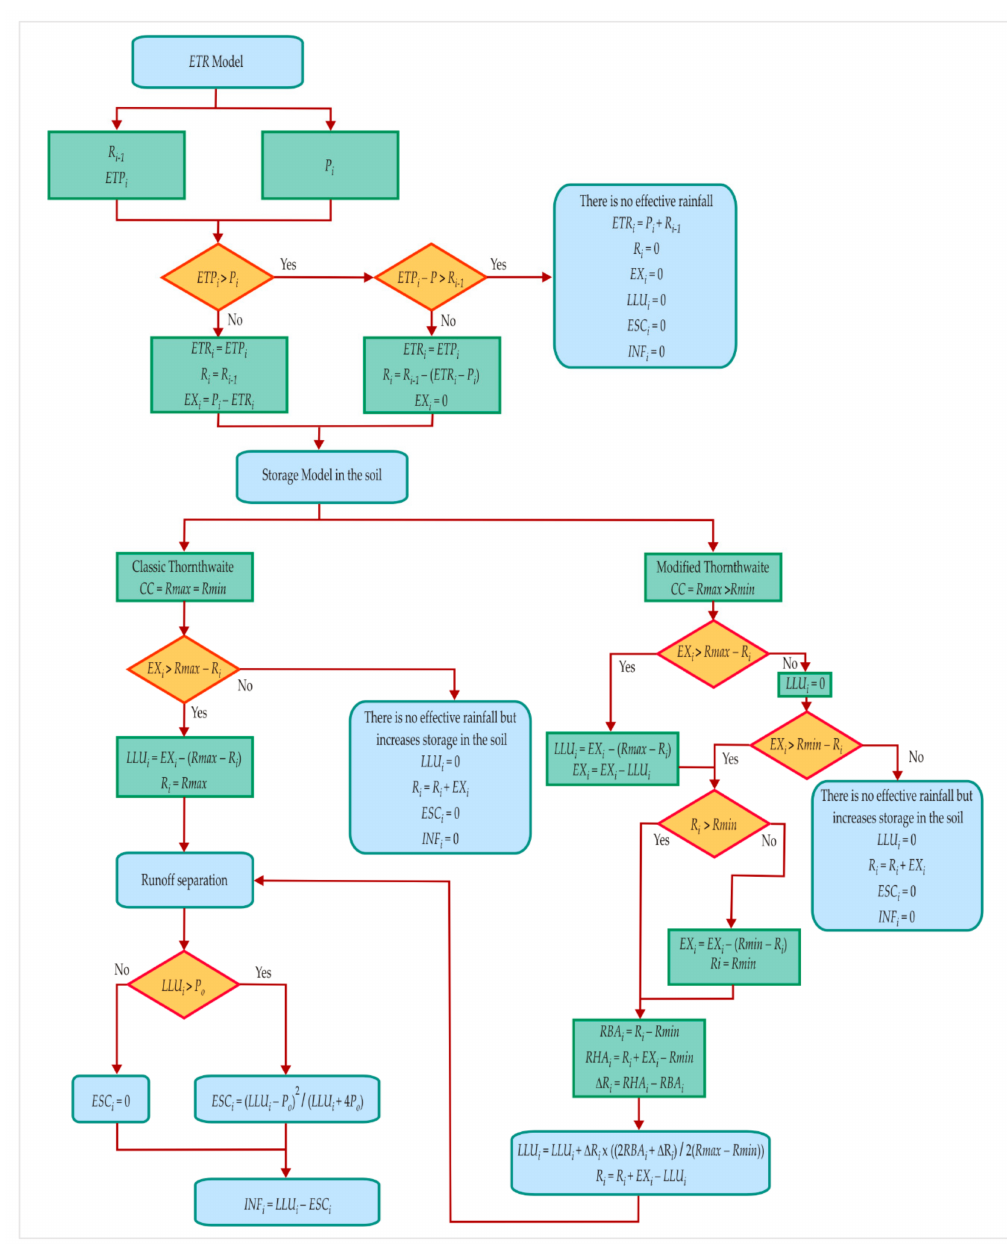
Figure 5. Algorithm for soil water balance, implemented in Natural Aquifer Recharge (RENATA)